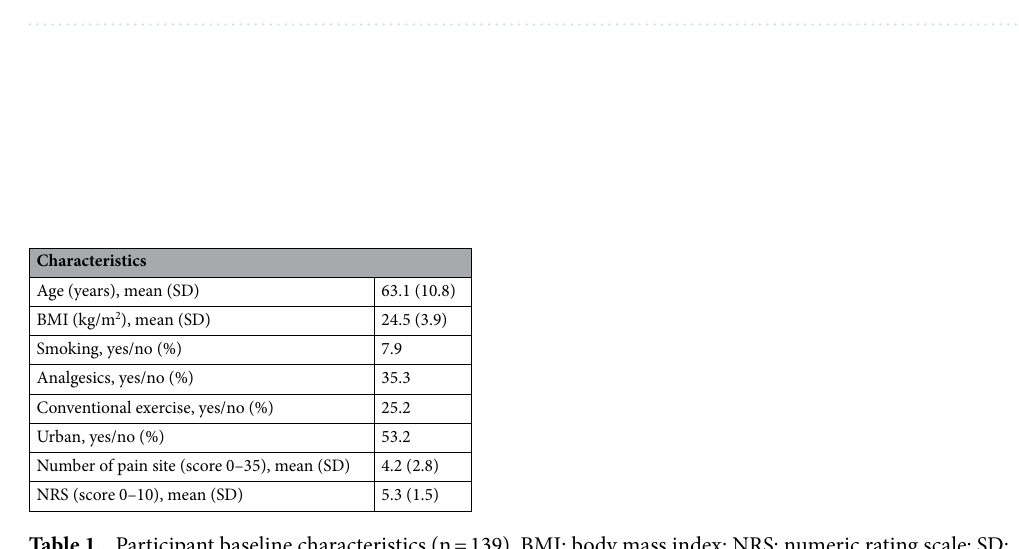
Figure 1. Flow diagram of participant selection. CMP = chronic musculoskeletal pain , NRS = numeric rating scale.